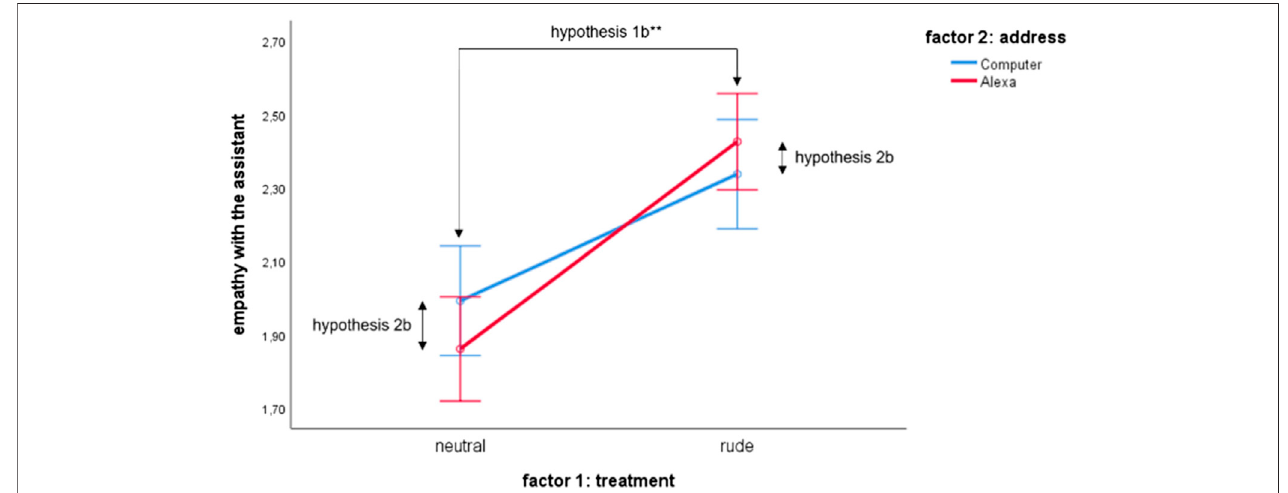
FIGURE 3 | Effects of treatment and form of address on empathy subscale with the CA (controlled for trait empathy).